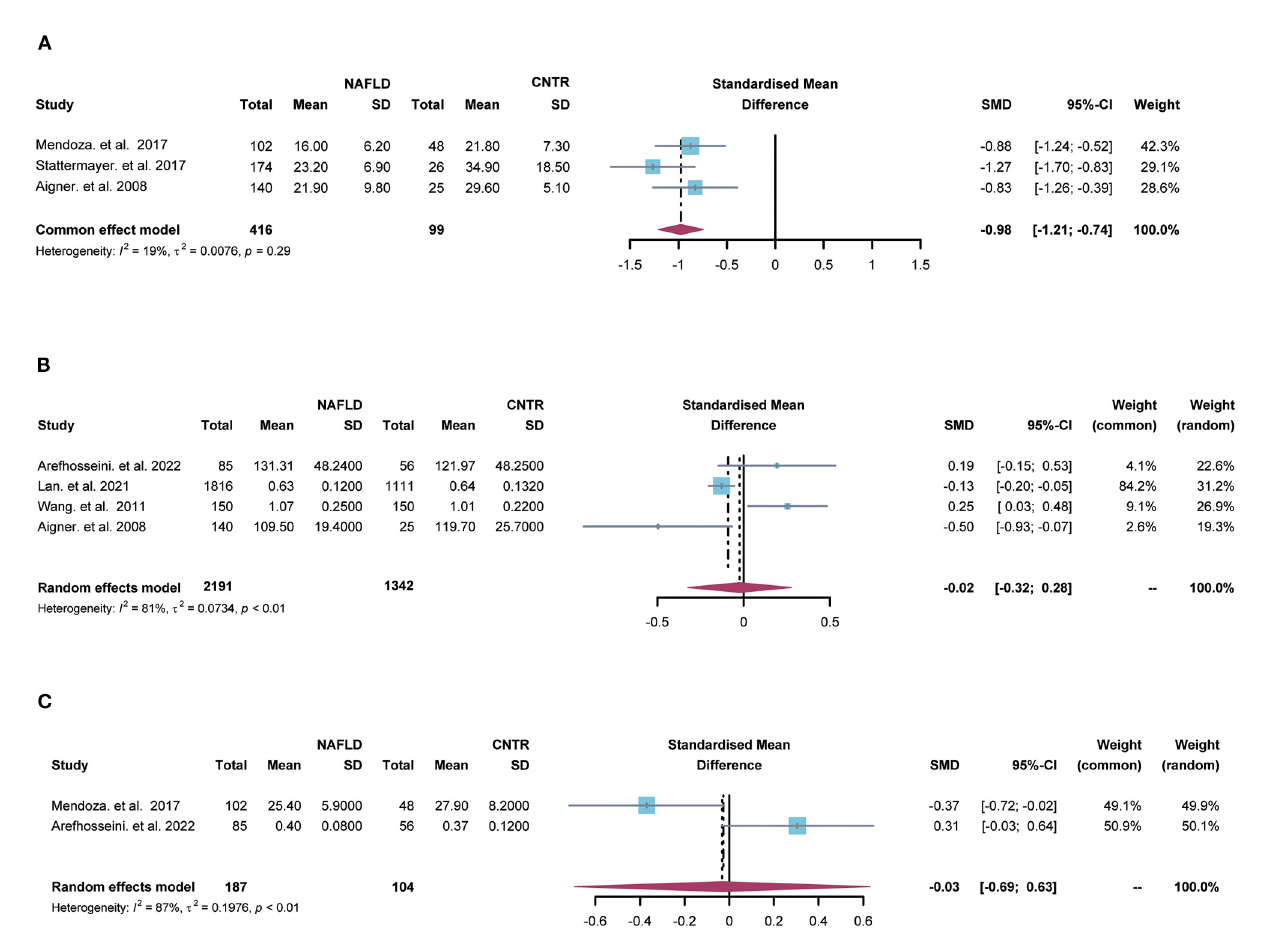
FIGURE2 The forest plots for comparisons of hepatic copper (A) , serum copper (B) and ceruloplasmin (C) between NAFLD and the control group. SD, standard deviation; SMD, standardized mean differences; CI, confidence interval.